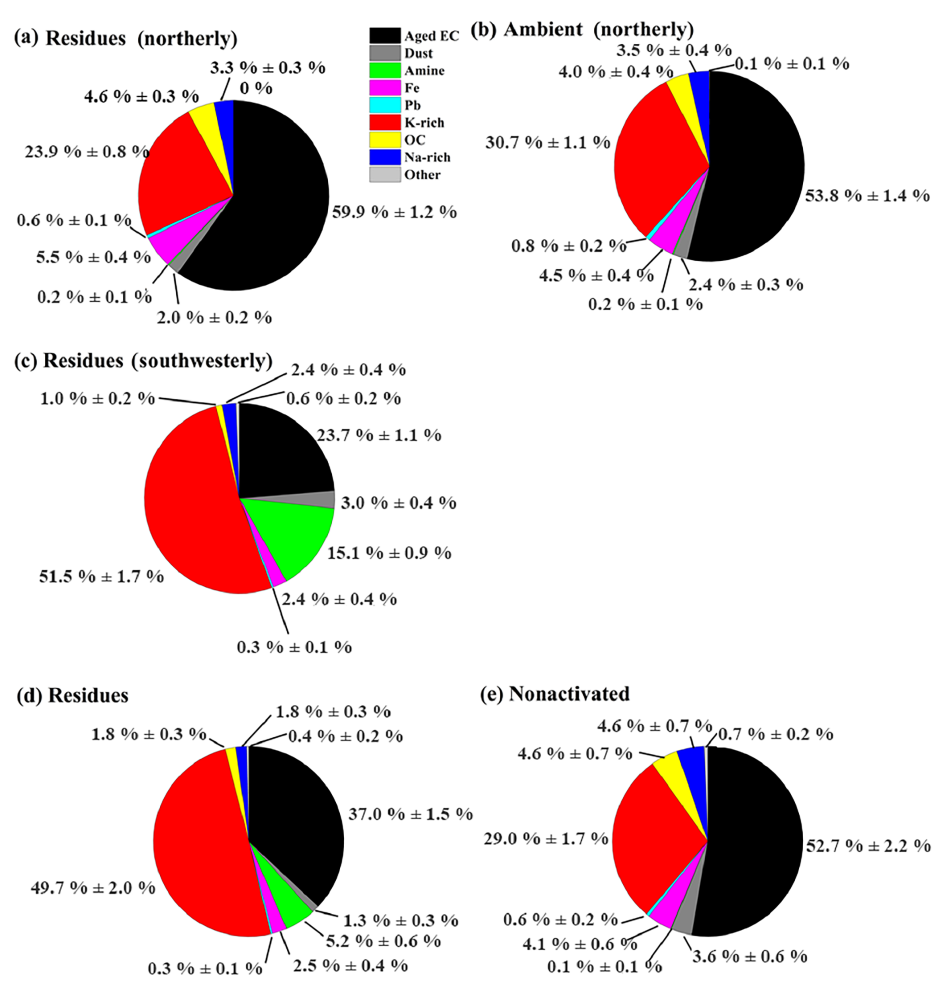
Figure 7. Number fractions of the cloud residues, ambient particles and nonactivated particles; (a) cloud residues during northerly air mass; (b) ambient particle during northerly air mass; (c) cloud residues during southwesterly air mass; (d) cloud residues; and (e) nonactivated particles were alternately sampled with an interval of 1h during the cloud III event. Uncertainties were calculated assuming Poisson statistics for analyzed